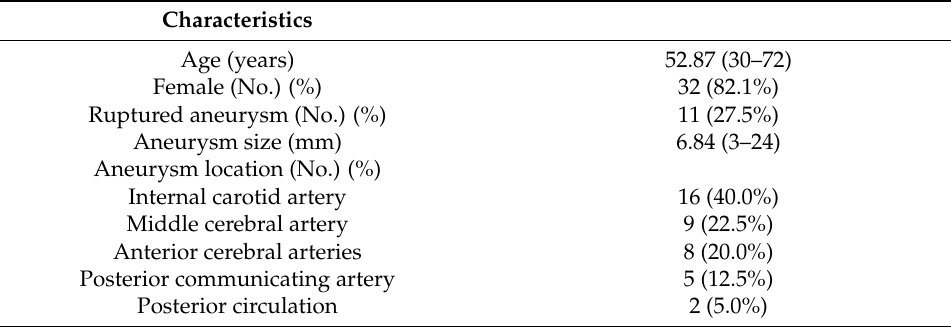
Table 1. Patient and aneurysm